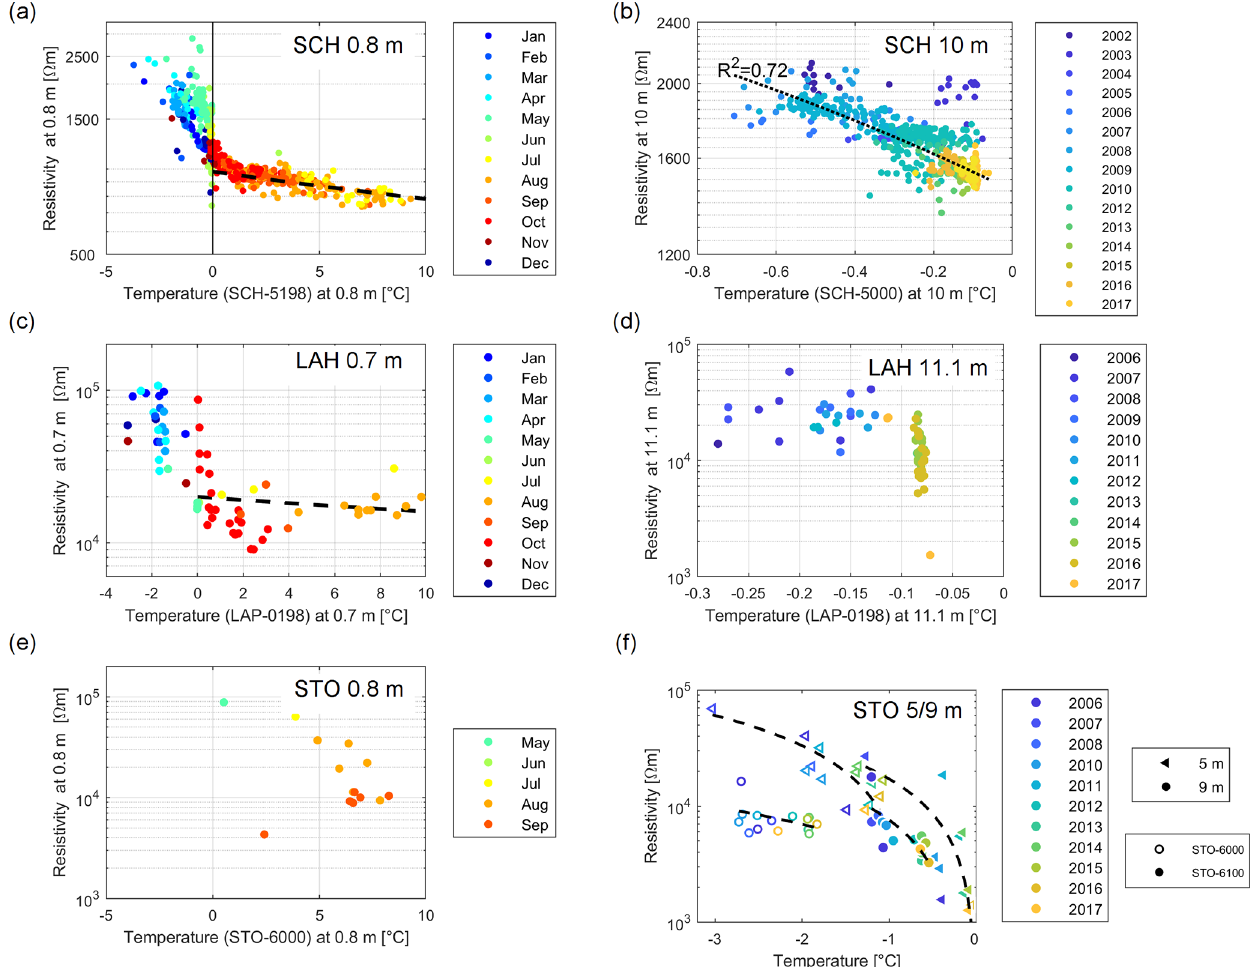
Figure 8. Example of resistivity–temperature scatter plots at SCH, STO, and LAH at shallow depth (left column, where the colour scale denotes months) and within the permafrost (right column, where colour scale denotes the years). (a) SCH at 0.8m depth, where a hysteresis loop is observed (direction indicated by black arrow) at shallow depth. The dashed line shows the linear dependency above the freezing point (0.025K − 1 ). (b) SCH at 10m depth: the dotted line corresponds to a linear regression. (c) LAH at 0.7m depth: the dashed line shows the linear dependency above the freezing point (0.025K − 1 ). (d) LAH at 11.1m depth. (e) STO at 1.3m depth and (f) STO for both boreholes, STO-6000 (unfilled symbols) and STO-6100 (filled symbols). Symbols denote the depth. Dashed lines fit the data for each depth and each